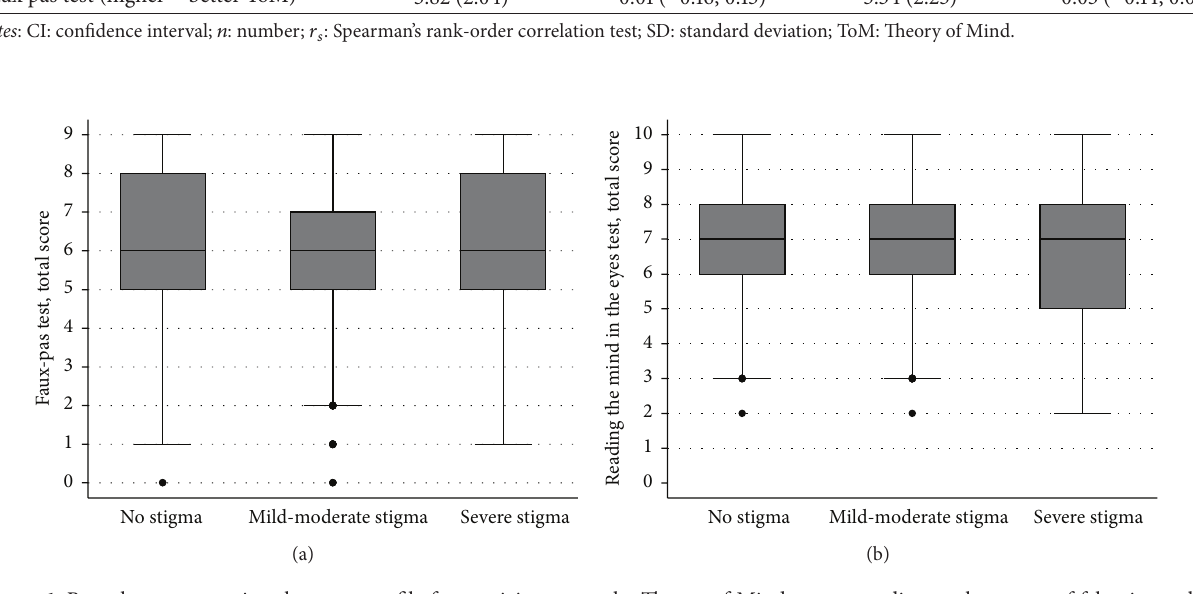
Table 2: Association between Theory of Mind test performance and stigma score according to participant’s seizure status. Theory of Mind test Mind in eyes test (higher = better ToM)